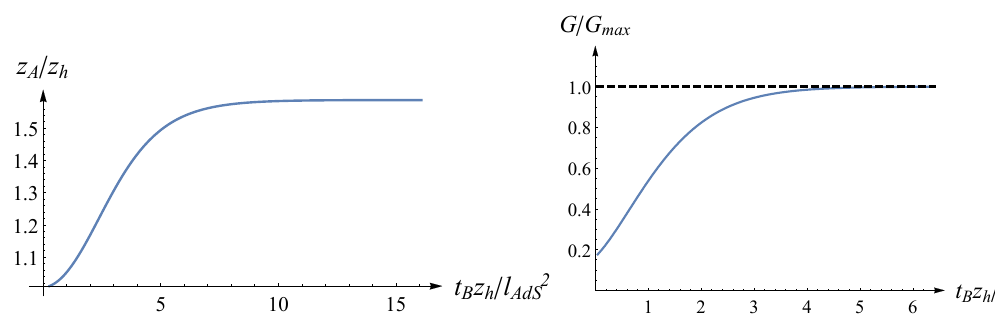
Figure 3 . Left: the image of z A and t B . Right: the image of G ( z A ) and t B . Here we set d = 3 , ‘ AdS = 100 , and f ( z ) = h ( z ) as 3.1 with k = 0 . z = z for very late times (see figure 4). If G ( z ) has multiple one extreme points, saying ext { z , z , z , · · · } with z < z < z < · · · , z will approach to the ext , 1 ext , 2 ext , 3 ext , 1 ext , 2 ext , 3